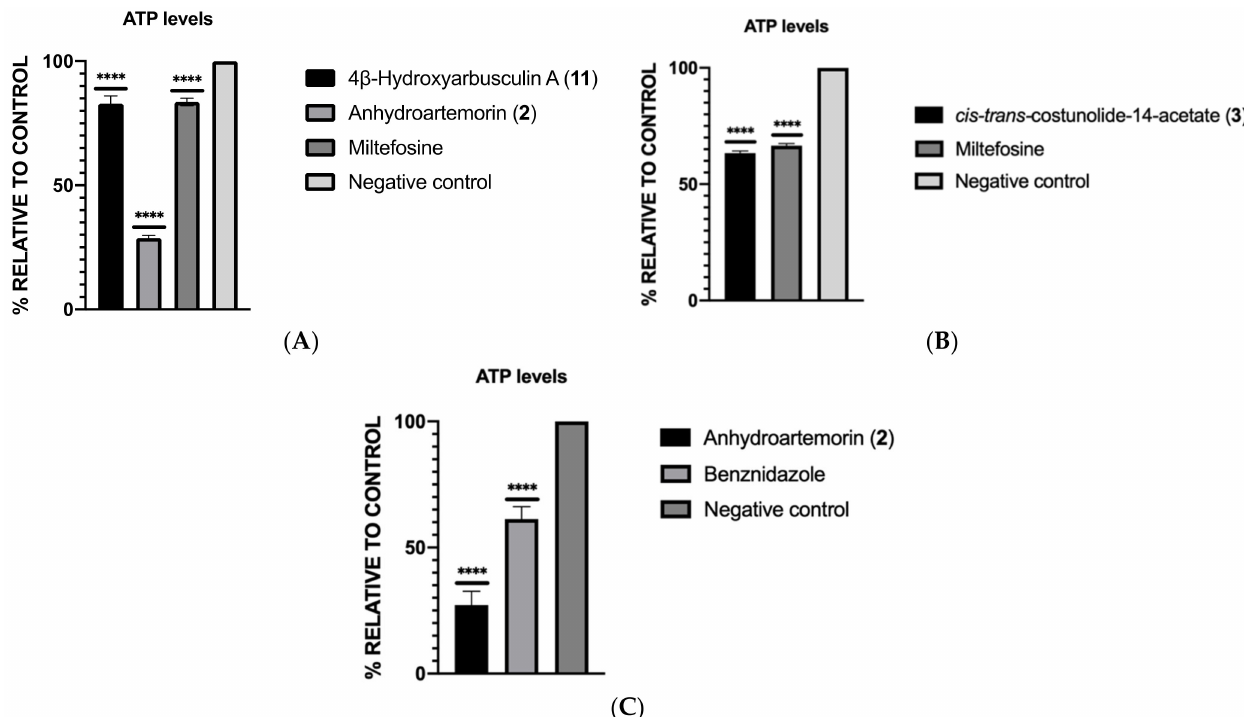
Figure 4. Percentage of ATP relative to the negative control in L. amazonensis ( A ), L. donovani and ( B ) and T. cruzi ( C ). A one-way ANOVA by GraphPad.PRISM ® 9.0 software was performed to know the statistical differences between compounds and untreated control ( p < 0.0001 [****]) ( n = 3).